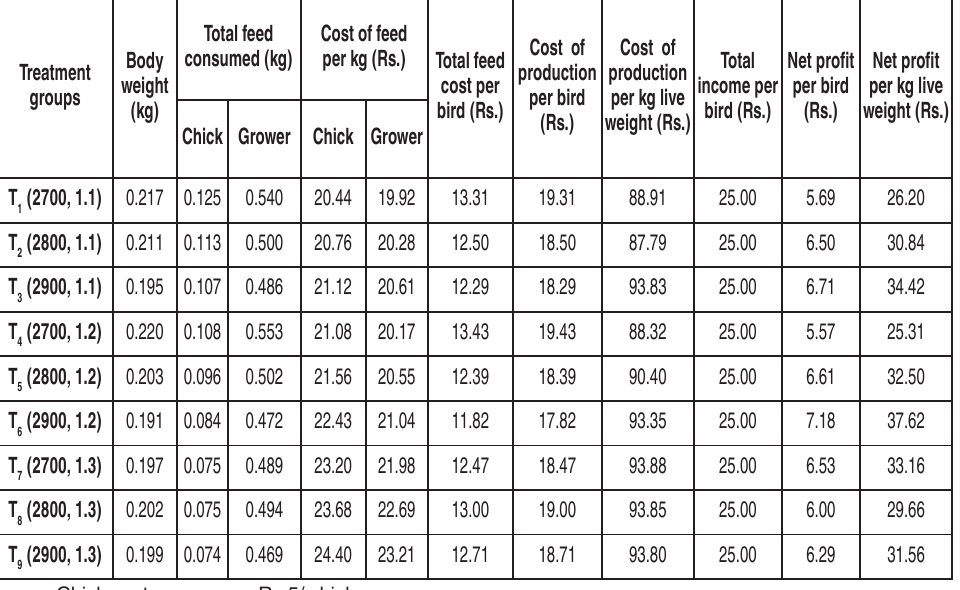
Table 2. Cost effectiveness of TANUVAS Namakkal gold Japanese quail from 1 to 5 weeks of age (chick cum grower) as influenced by different levels of energy and lysine